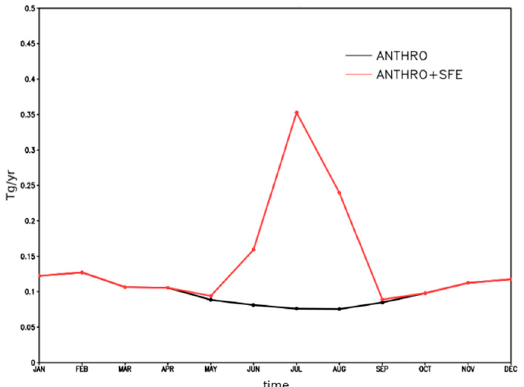
Figure 9. Annual variation of BC emission in the Arctic in Tg/year. Black curve—anthropogenic emissions, red curve—anthropogenic and fire components.